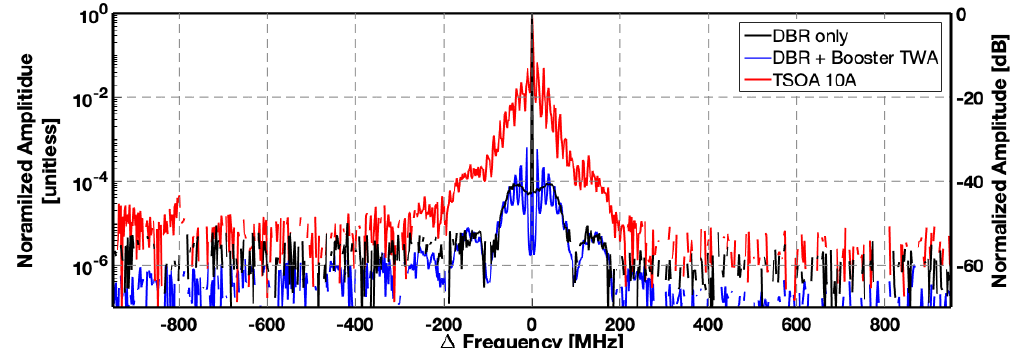
Figure 7. Spectra of butterfly-packaged DBR seed laser (black), seed and booster TWA (blue), and final amplifier stage output (red). The DBR seed (5.5mW) and DBR plus booster amplifier (19.5mW) are continuous wave. The TSOA output was pulsed (39mW average power, 7.8W peak power with 625ns duration pulses at 8kHz) and has > 99 . 9% of the energy contained within the central ± 100MHz spectral region.